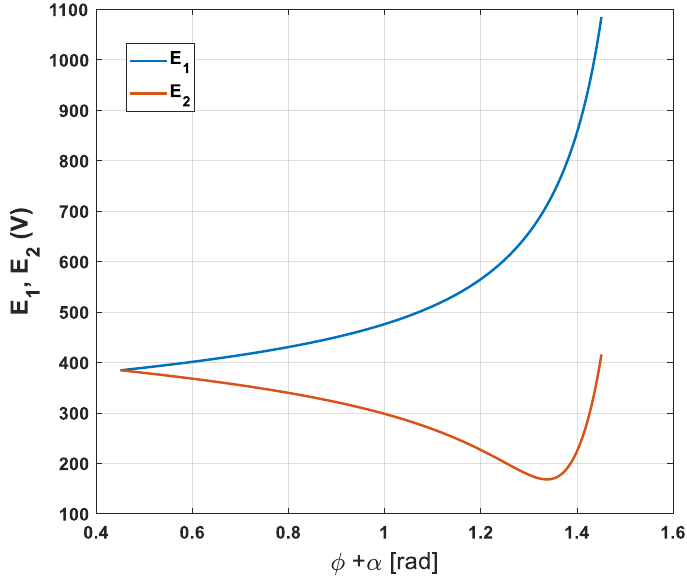
2 on the angle ( φ + α ).